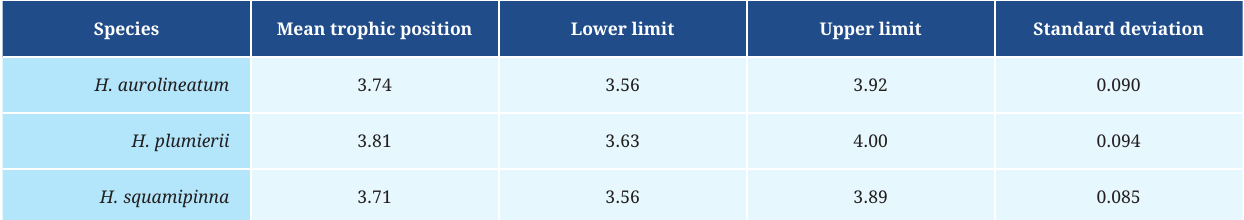
TABLE 4 | Trophic position of Haemulon species estimated based on the stable isotopes analysis (TP α= 95%, and its standard Species